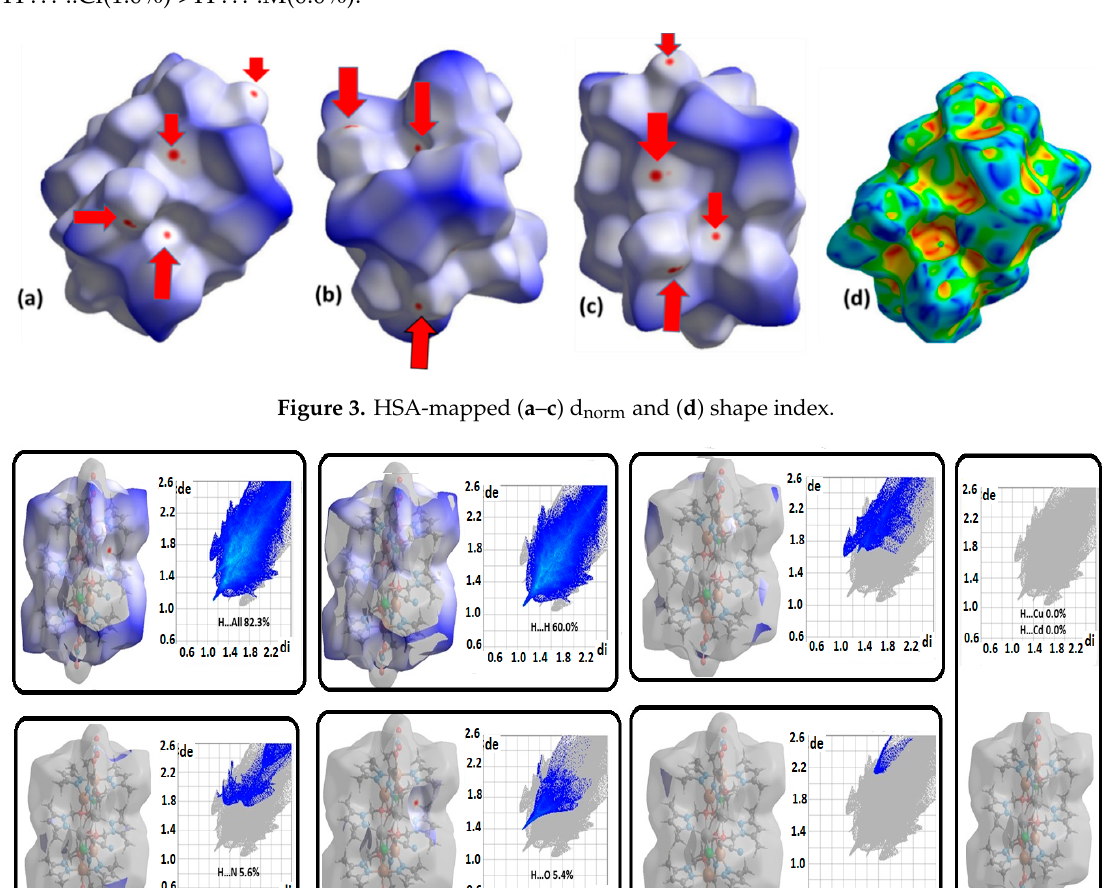
Figure 3. HSA-mapped ( a – c ) d norm and ( d ) shape index.